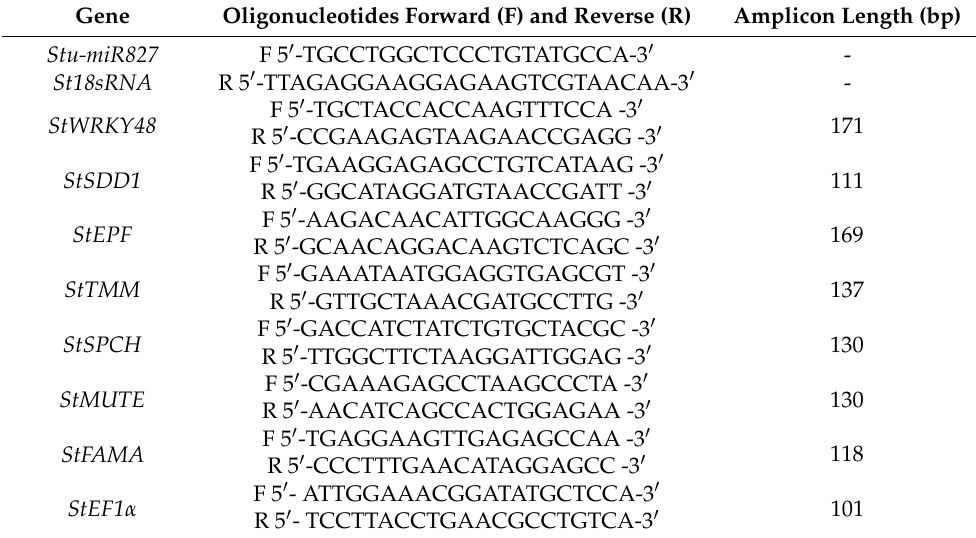
Table 3. Oligonucleotides used for RT-qPCR analysis.